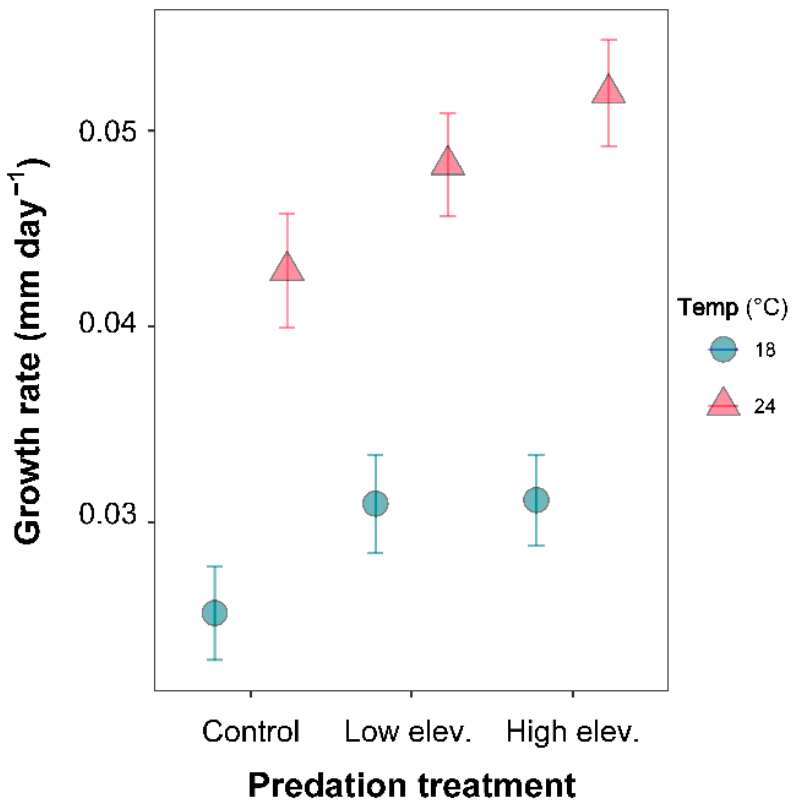
Figure 2. Growth rate of Sympetrum striolatum larvae in the combination of two temperature and three predator treatments. Error bars are 95% confidence intervals.